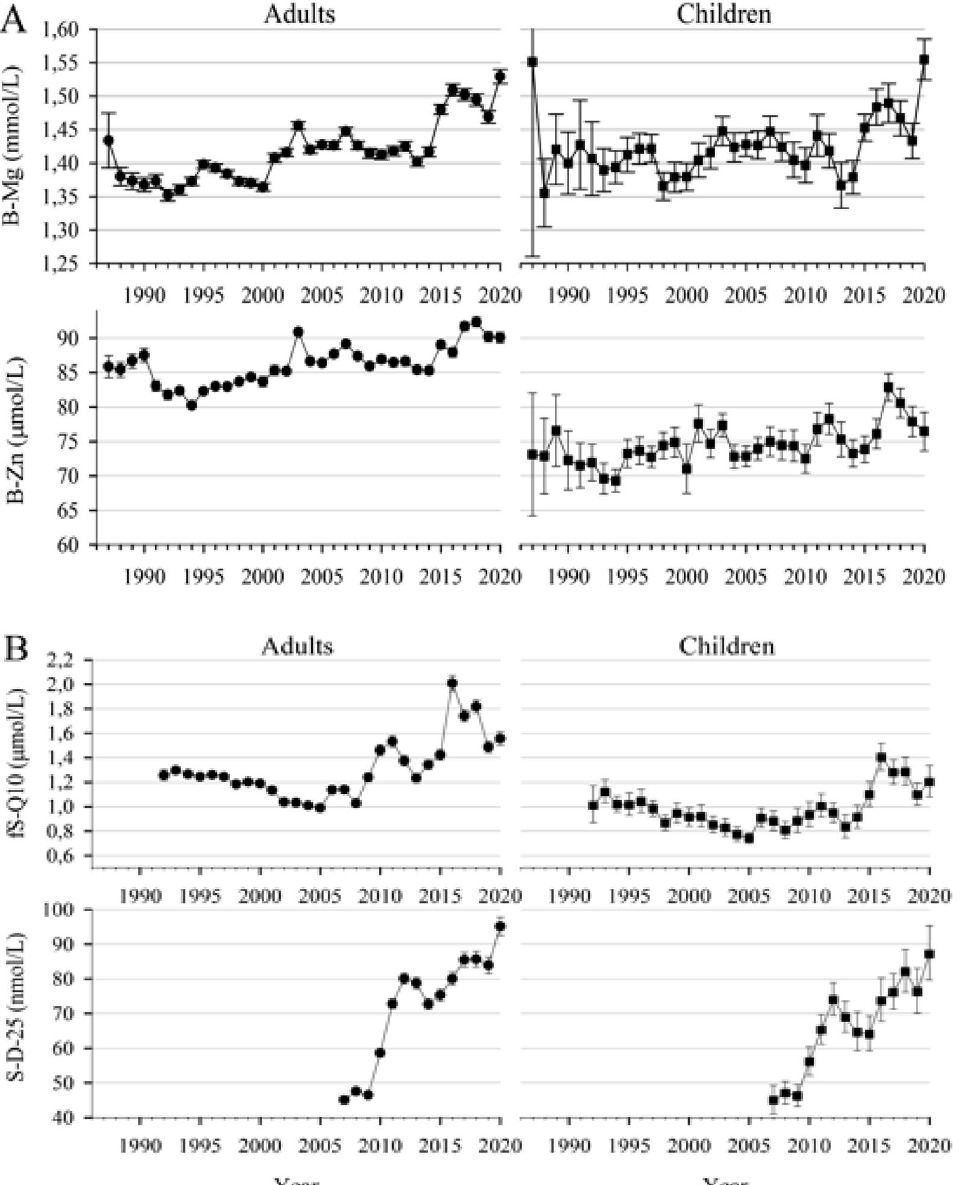
Figure 1. Micronutrient levels in adults ( ● age ≥ 18) and in children ( ■ age < 18) measured during 1987–2020. ( A ) Means (95% CI) of B-Mg and B-Zn. ( B ) Geometric means (95% CI) of fS-Q10 and S-D-25. The numbers of results varied from year to year: B-Mg (n = 130–2347 for adults and n = 8–165 for children); B-Zn (151–2523 and 8–201); fS-Q10 (725–1889 and 25–132); S-D-25 (800–1854 and 76–143).